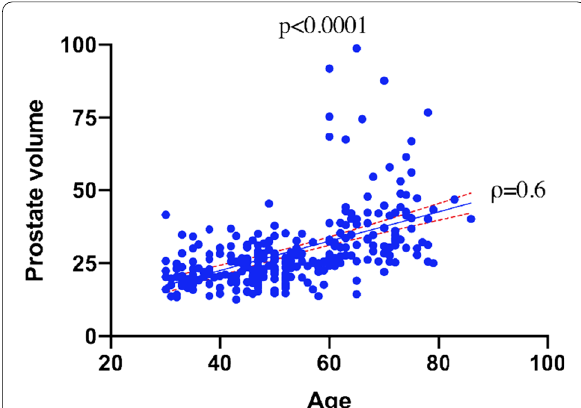
Fig. 1 Scatter plot showing the correlation between serum PSA